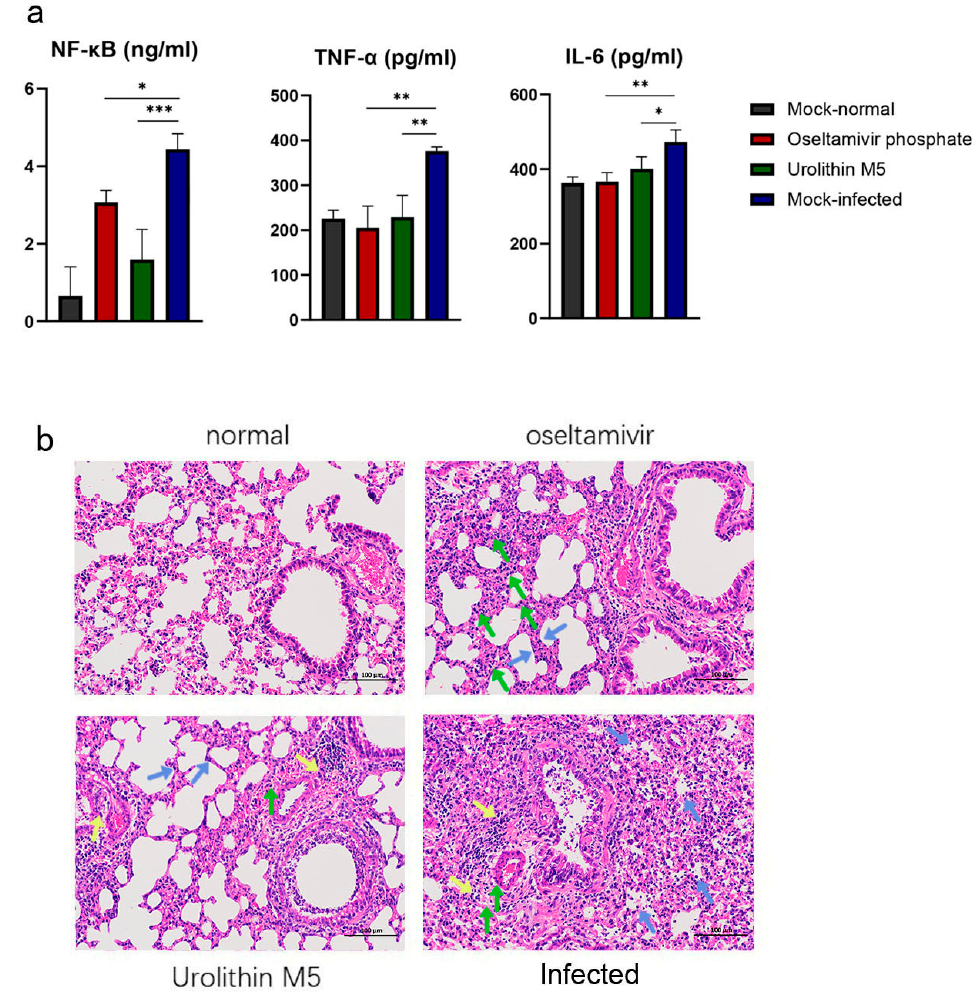
Figure 4. ( a ) Effect of urolithin M5 treatment on NF- κ B, TNF- α and IL-6 levels using ELISA assay. ( b ) Histopathologic changes of mice from the normal group, oseltamivir group, urolithin M5 group, and vehicle group on the fourth day. Inflammatory changes are labeled as interstitial expansion (green arrow), small vessel inflammatory cell infiltration (yellow arrow), and alveolar lumen inflammatory cell infiltration (blue arrow) (magnification: 200×). (* p 0.05, ** p 0.01, *** p 0.001).